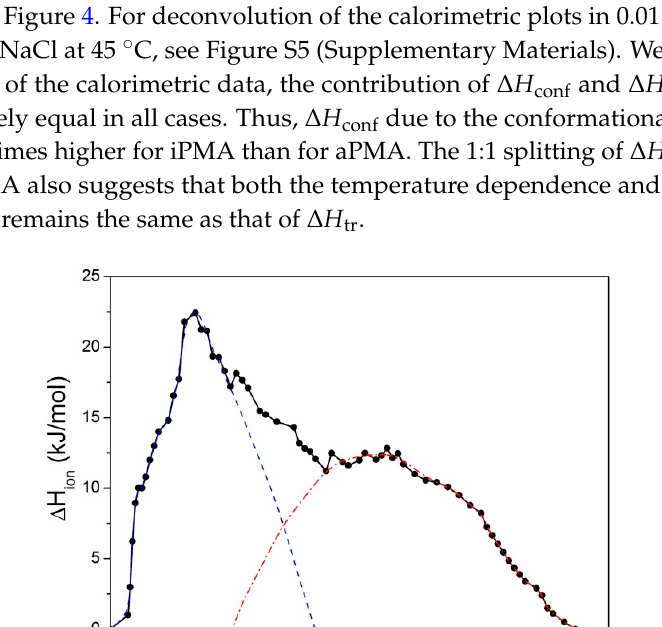
Figure 6. Enthalpies of dilution of iPMA and aPMA solutions in water (no added salt) at 25 °C as a function of the degree of ionization, α . The initial concentration, c in , of PMA is c in = 0.065 M (= mol of carboxyl groups per volume) and the final one, c f , is c f = 0.0325 M. For comparison, the literature data [23] for aPMA, sPMA, and PAA are shown (note that in Reference [23] c in was 0.065 M and c f was 0.0433 M).